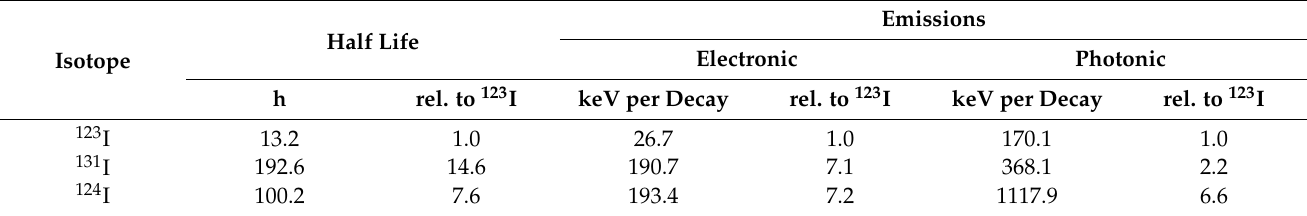
Table 1. Pertinent iodine radioisotope properties [5].